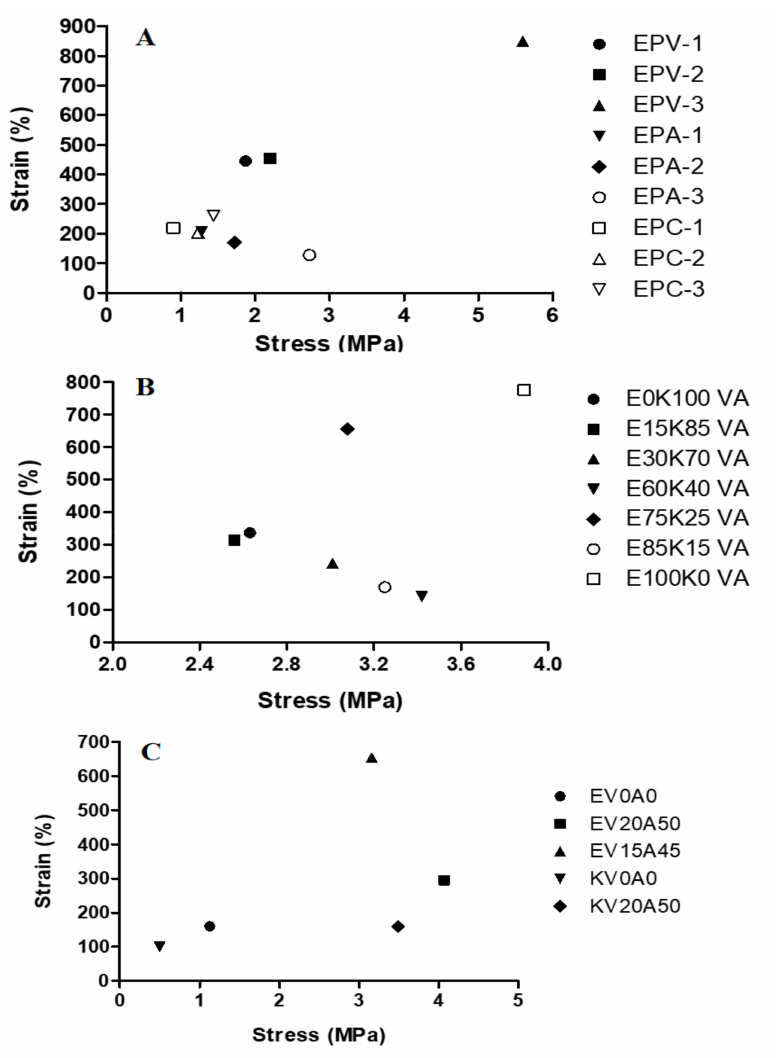
Figure 6. Plots of tensile stress versus tensile strain of ( A ) phase-1, ( B ) phase-2, and ( C ) phase-3 composites. The effect of loading of Vulkasil-C and asbestos on tensile stress and strain of EPDM composites (phase-2) is shown in Figure 6B. EPDM-Keltan sample (E0K100VA) with two fillers have shown comparatively low mechanical properties than that of EPDM-Esprene sample (E100K0VA) with the same quantity of fillers. I could be diagnosed that EPDM- Esprene may have better compatibility with the fillers as compared to EPDM Keltan. For samples E15K85VA, E30K70VA, E60K40VA, and E85K15VA, increase in the stress and decrease in the strain were observed, while an anomalous behavior was observed for the sample E75K25VA where stress and strain both increased. The decrease in the strain was related to the quantity of a filler in phase-1 composites, however, in phase-2 composites, two fillers were used which combinedly may have affected the elasticity of EPDM. The lowest stress and strain for E0K100VA (2.63 MPa, 338%) and E15K85VA (2.56 MPa,